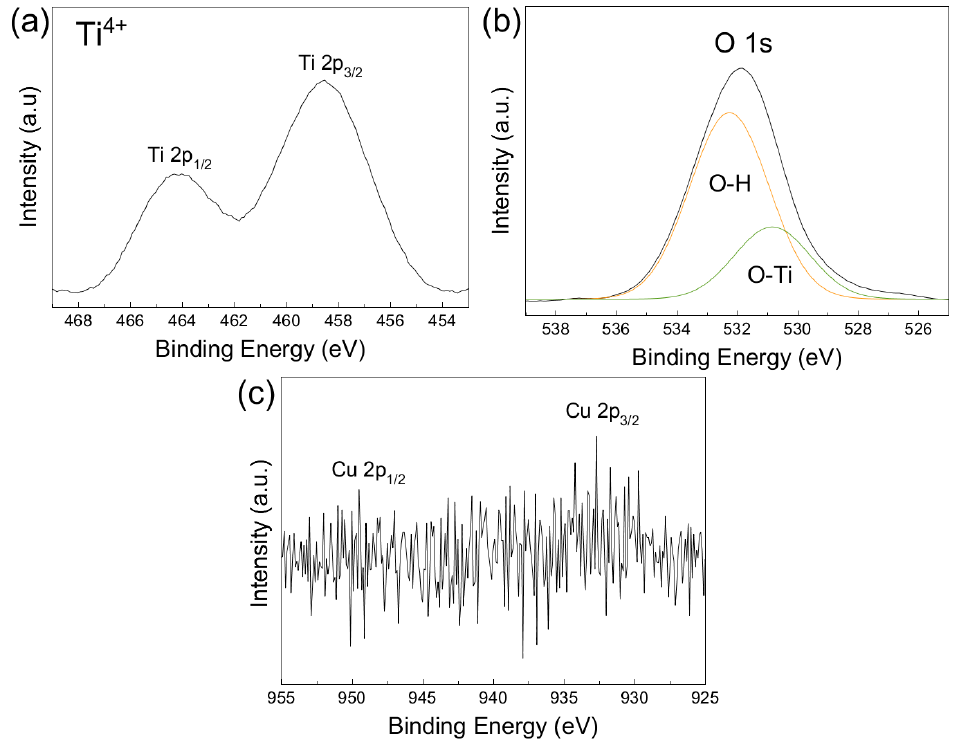
Figure 6. XPS spectra of ( a ) Ti 2p, ( b ) O 1s, and ( c ) Cu 2p for the Cu/TiO 2